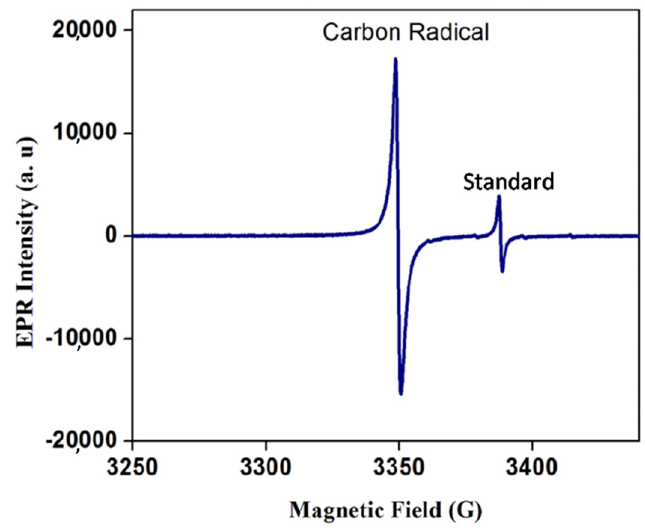
Figure 4. Spectrum of the p-C / TiO 2 system; Cr + 3 was the internal standard.